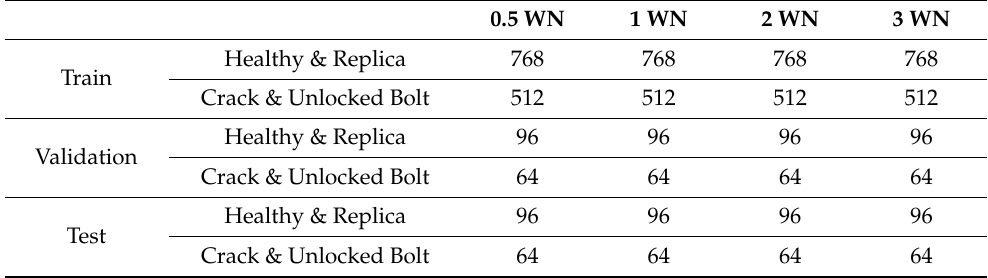
Table 3. Number of images used in the train, validation, and test sets per white noise (WN) amplitude factor and per studied class for damage detection.